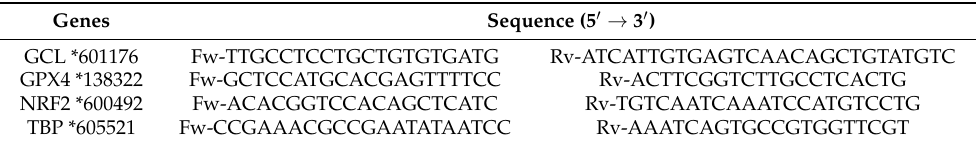
Table 2. Primers used for qRT-PCR